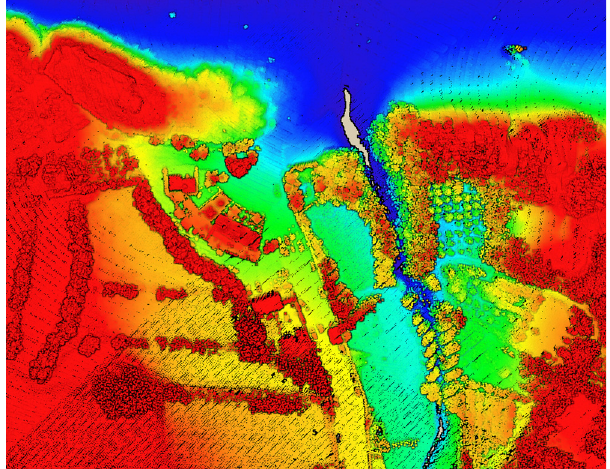
Figure 10: An elevation model of the bay obtained from LiDAR